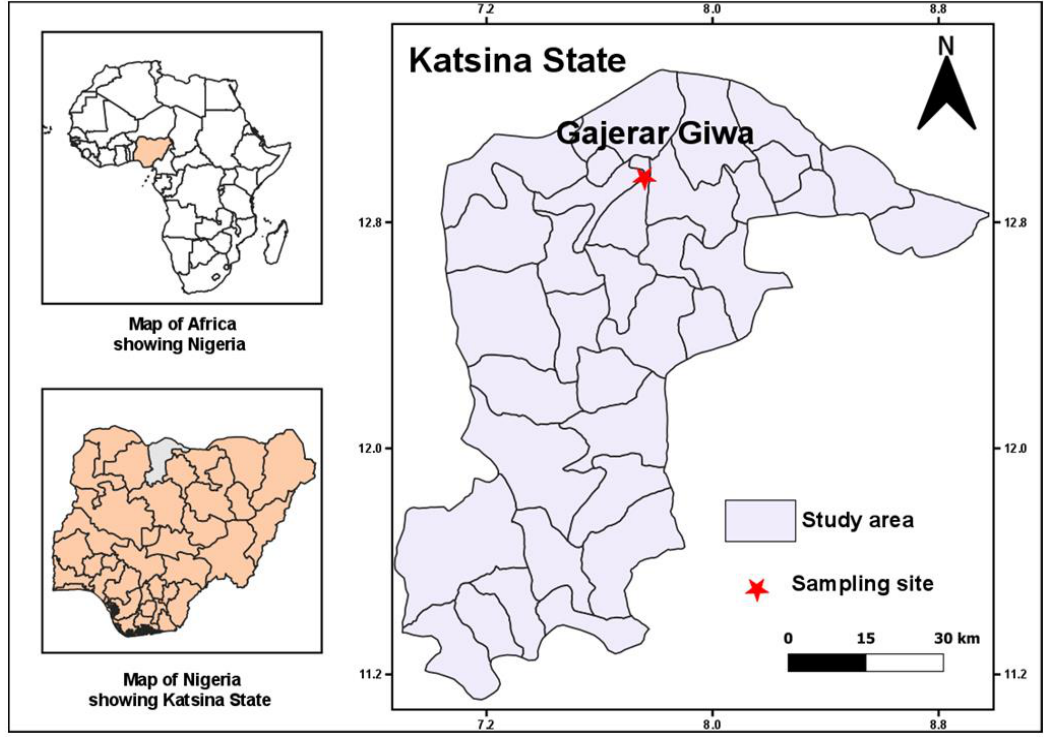
Figure 1. A map showing the sampling locality (Gajerar Giwa) in the Sahel of northern